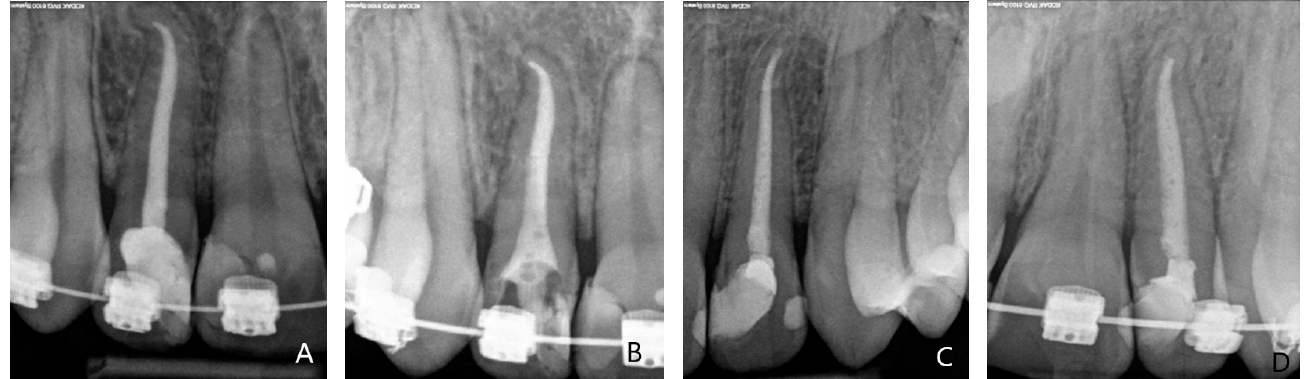
Figure 8. An anterior intraoral periapical radiograph taken during treatment with fixed orthodontic appliances. ( A , C ) Baseline intraoral periapical radiograph taken at the first appointment: Endodontically treated lateral maxillary incisor with atypical root shape (root apex curvature), maxillary central incisor (vital), with a typical morphology of the root. ( B , D ) Intraoral periapical radiographs taken at the third/fourth appointment: Mild external apical root resorption of lateral maxillary incisor and flattening of the apex of central maxillary incisor.